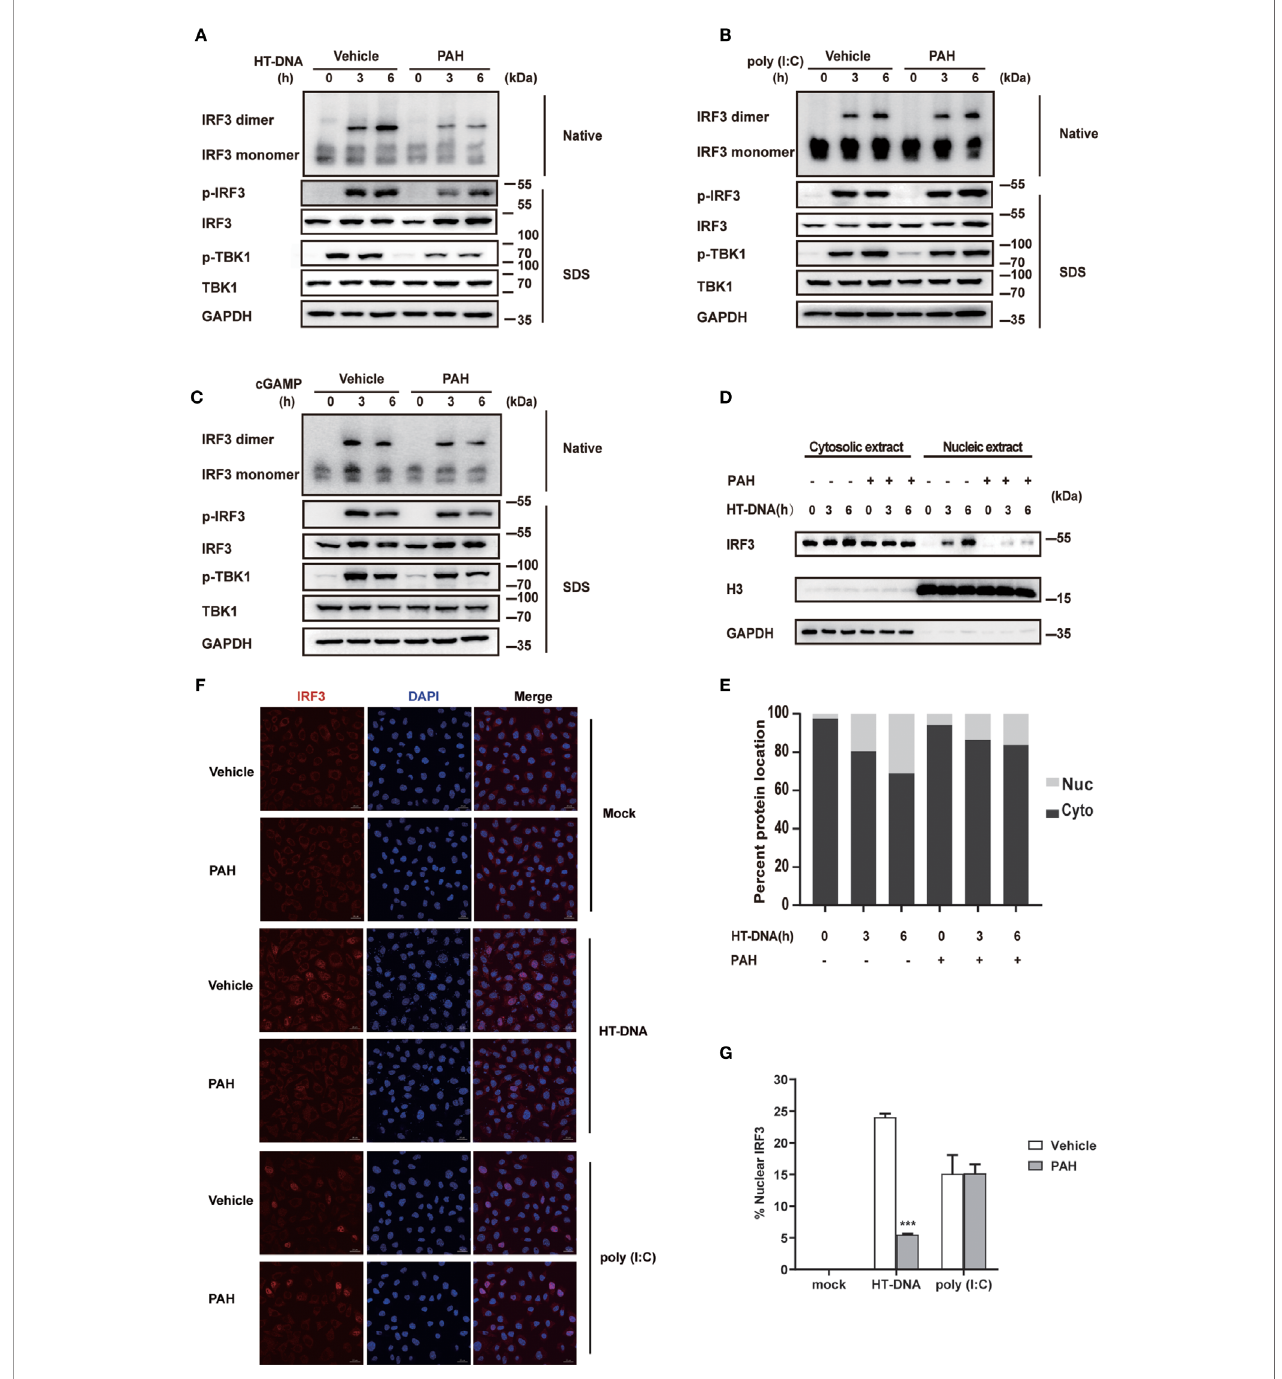
FIGURE 3 | PAH suppresses cGAS-mediated innate immune response. (A – C) L929 cells were treated with Vehicle or PAH (200 m M) for 6 h and then stimulated with HT-DNA (4 m g (cid:129) ml − 1 ) (A) , poly(I:C) (3 m g (cid:129) ml − 1 ) (B) , or cGAMP (1 m g (cid:129) ml − 1 ) (C) for the indicated times. The cell extracts were analyzed for TBK1 and IRF3 phosphorylation by SDS-PAGE or IRF3 dimerization by native PAGE. (D, E) L929 cells were treated with Vehicle or PAH (200 m M) for 6 h and then stimulated with HT-DNA (4 m g (cid:129) ml − 1 ) for the indicated times. The IRF3 protein levels in cytoplasmic (Cyto) and nuclear (Nuc) fractions were analyzed by immunoblot (D) . The relative ratio of indicated proteins in Cyto and Nuc was analyzed by Image J (E) . (F) L929 cells were treated with Vehicle or PAH (200 m M) for 6 h, and then stimulated with HT-DNA (4 m g (cid:129) ml − 1 ) or poly(I:C) (3 m g (cid:129) ml − 1 ) for 4 h before staining with an antibody against IRF3 (red) and imaged by confocal microscopy. Scale bars represent 10 m m. (G) The relative ratio of nuclear IRF3 from (F) was analyzed by Image J. All of the experiments were repeated at least three times. Data in (G) are presented as mean ± SD. *** p <